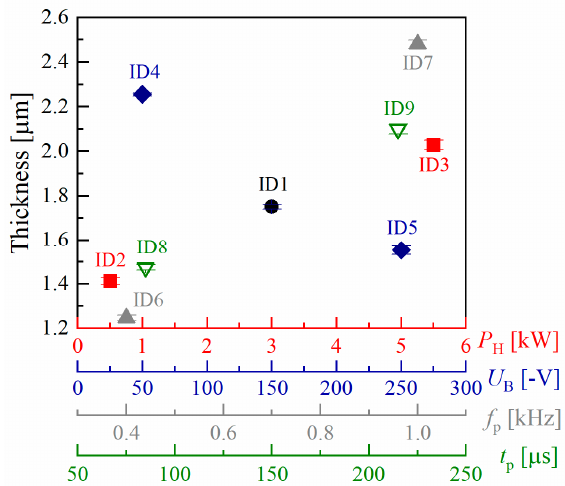
Figure 3. Dependence of the thickness of the HiPIMS MoS x films on the heating power P H and bias-voltage U B , for f p = 0.7 kHz and t p = 150 µs, as well as the pulse frequency f p and pulse duration t p , for P H = 3 kW and U B = − 150 V. Table 2. Statistical evaluation of the effects of the deposition parameters on different film properties using p - and t -values.